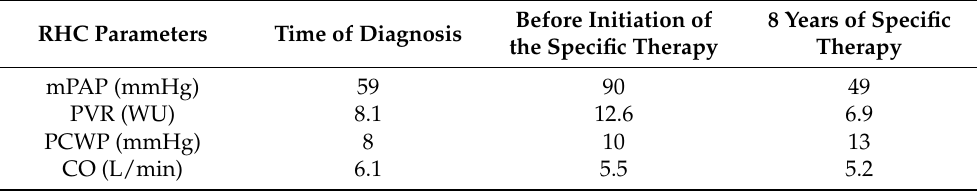
Table 1. Right heart catheterization hemodynamic parameters (Patient 1).